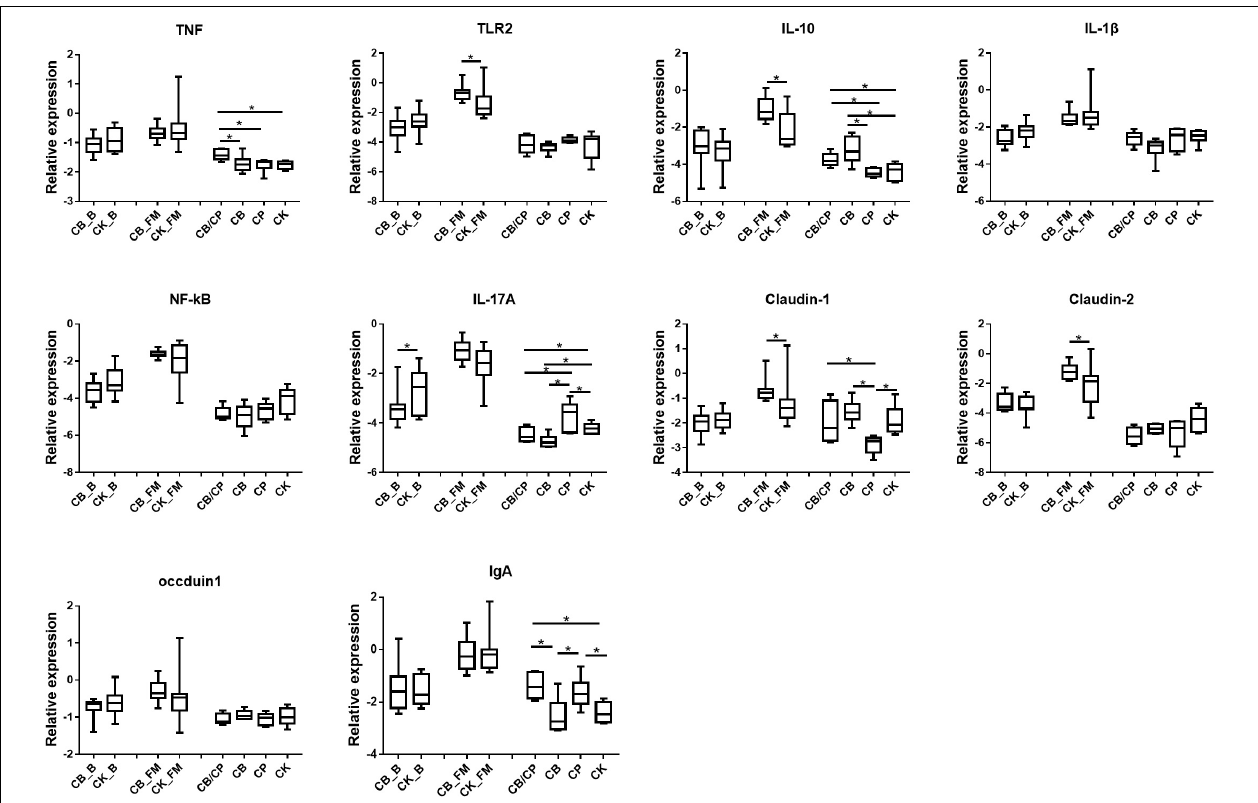
FIGURE 4 | Relative expression of immune and intestinal mucosa barrier-related genes in the ileum. Relative gene expression is represented as log 10 2 − (cid:49) Ct . Significant differences are indicated by an asterisk (ANOVA, ∗ p < 0.05). CB_B, CK_B, CB_FM and CK_FM: n = 12; CB/CP, CB, CP and CK: n = 6.